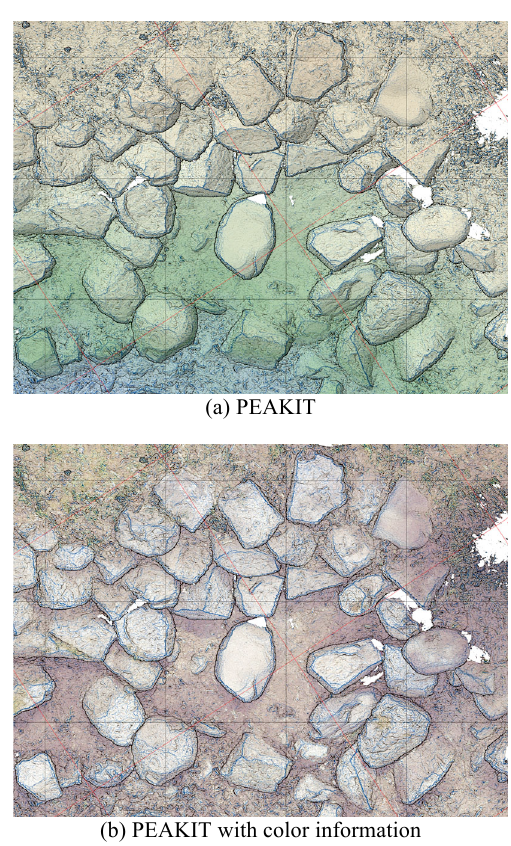
Figure 7. PEAKIT image of the garden